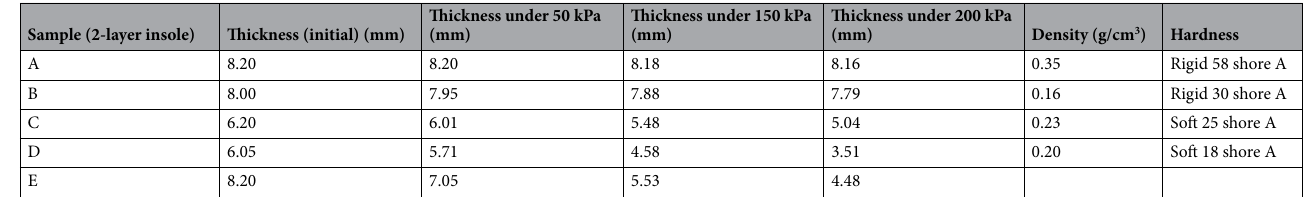
Table 1. Basic physical properties of studied insoles. A—Nora Lunalight A fresh; B—Pe-Lite; C—Nora Lunalastik EVA; D—PORON medical 4708; and E—Langer Biomechanics longitudinal PPT arch pads.